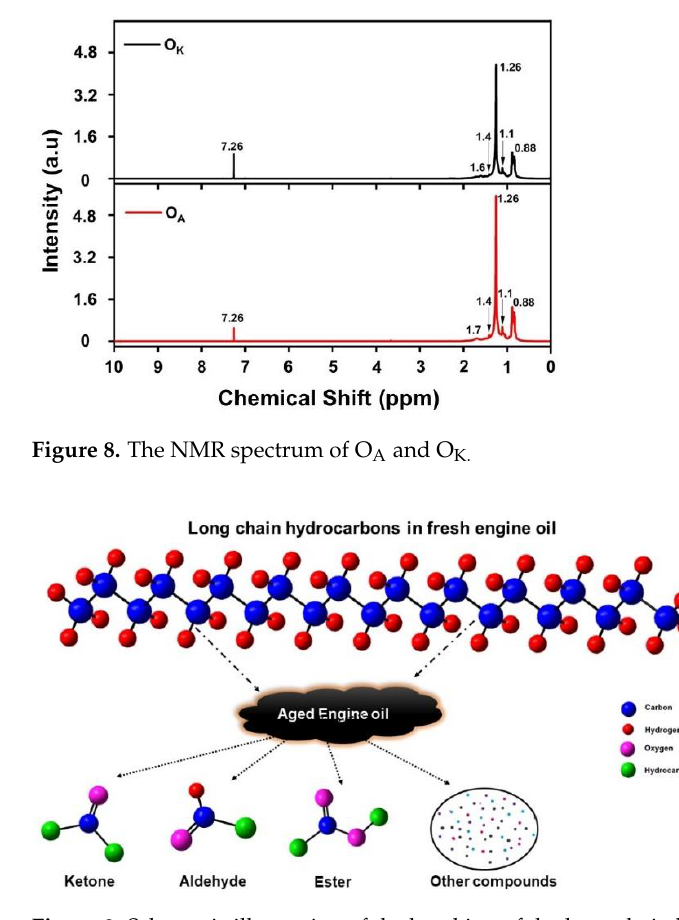
Figure 9. Schematic illustration of the breaking of the long-chain hydrocarbons in aged engine oil. The changes in the engine oil due to ageing (O A to O K ) change the optical absorption and nonlinear refractive index n 2 , which can be analysed by the closed aperture Z-scan technique. The variation in the transmitted intensity was analysed across the focal plane. The normalized transmittance versus z plot of the samples O A to O K for the laser power of 10 mW is shown in Figure 10a.